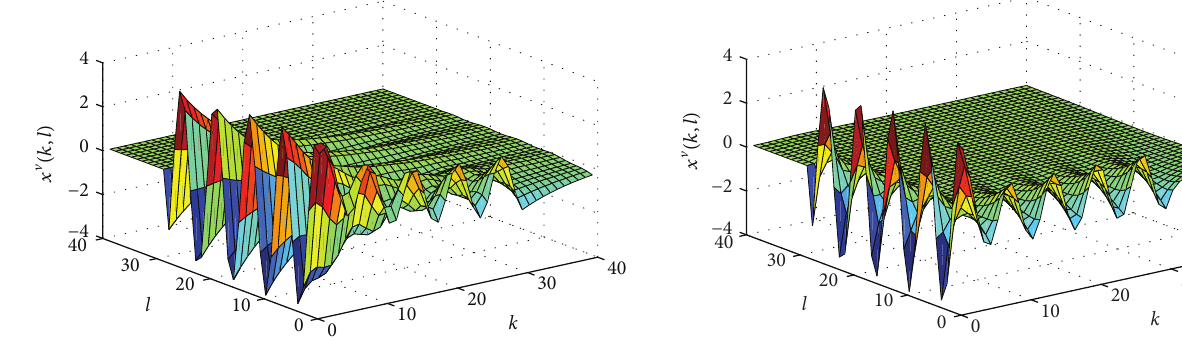
Figure 4: The state trajectory of 𝑥 V (𝑘, 𝑙) with 𝑎 2 = −2.9 .